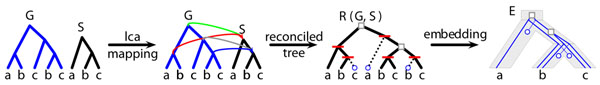
LCA-reconciliation. Example of a reconciliation based on a parsimony between the gene tree G and the species tree S. The reconciled tree defines the evolutionary scenario with the minimal number of gene duplications and gene losses. R(G, S) has two gene duplications, denoted by squares, and three gene losses, denoted by circles and dot lines. The red horizontal bars in R(G, S) denote speciation events.